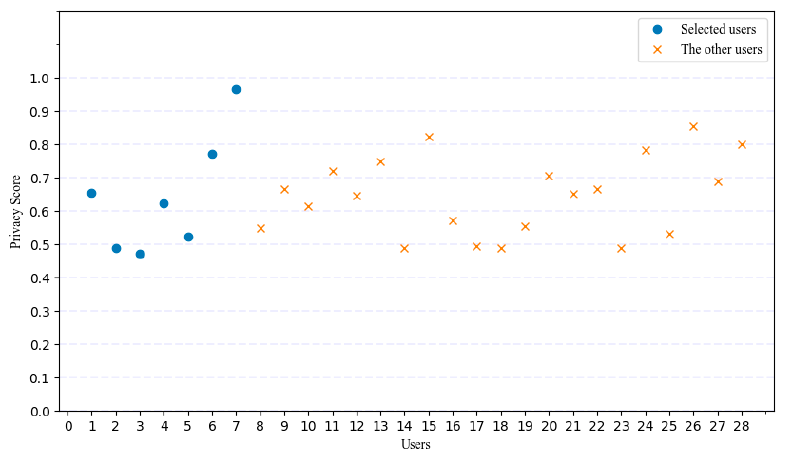
Figure 5. User privacy score statistics.